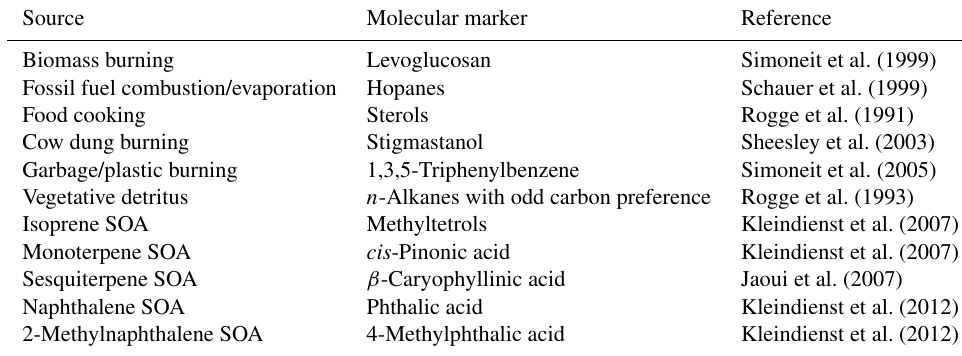
Table 1. Molecular markers for primary or secondary sources of particulate matter.